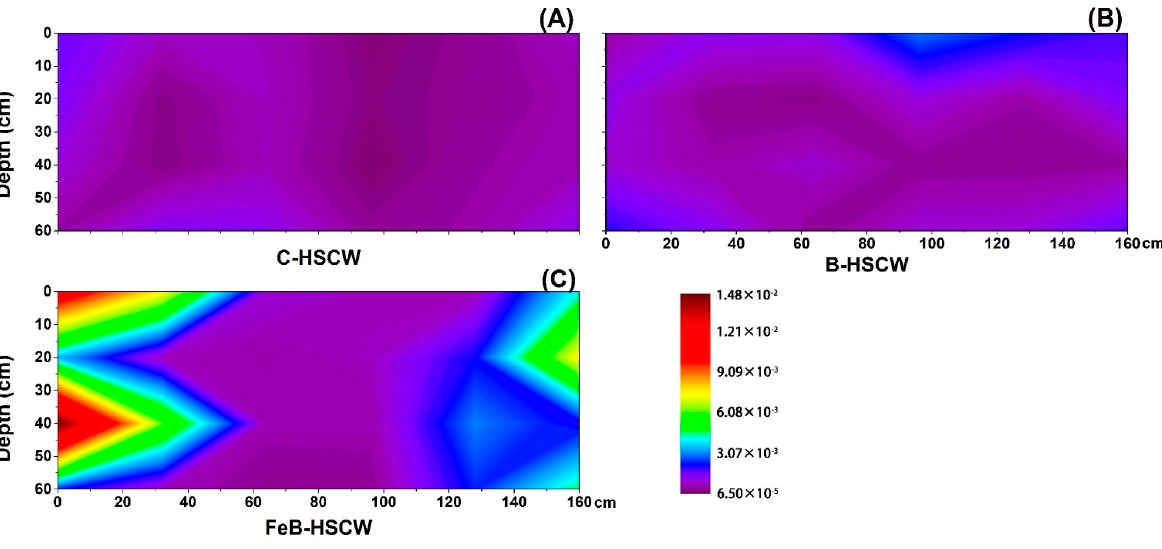
Figure 11. The spatial distribution of nosZ -II relative abundance in C-HSCW ( A ), B-HSCW ( B ), and FeB-HSCW ( C ) based on interpolated maps. Color scales indicate extrapolated values by kriging. C-HSCW, without biochar and FeB-modified biochar; B-HSCW, with biochar; FeB-HSCW, with FeB-modified biochar.